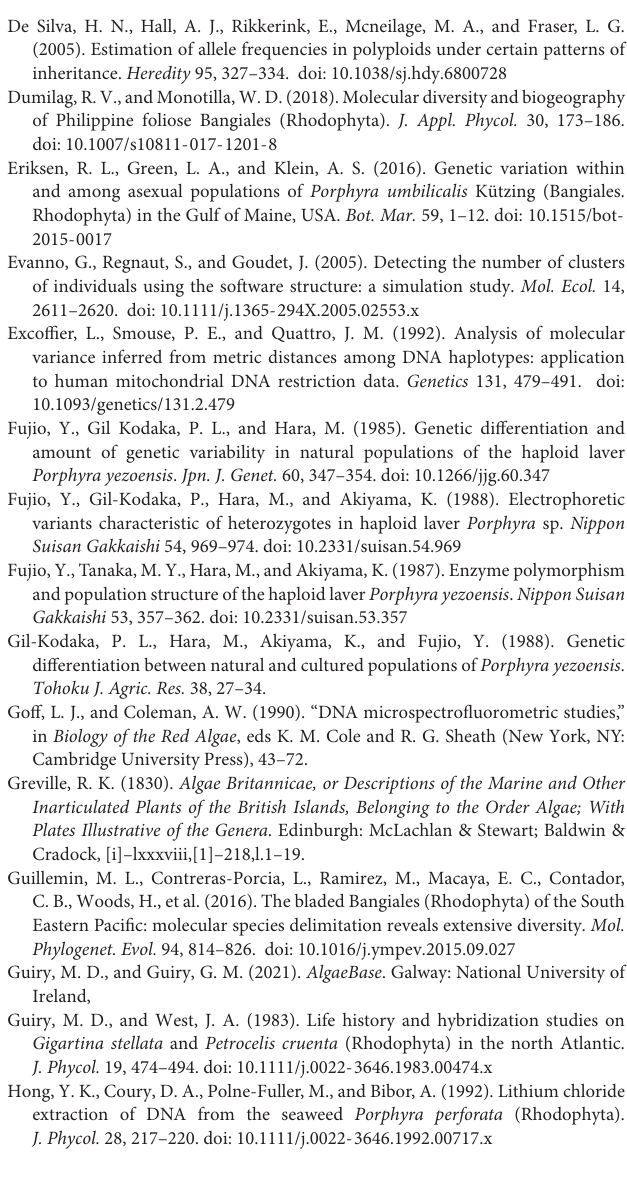
Supplementary Figure 2 | Genome constitution of the 442 genotypes inferred by S TRUCTURE to 2, 3, and 4 inferred clusters based in 10 microsatellite loci, considering the data as 4 × . Supplementary Figure 3 | Genome constitution of the 442 genotypes inferred by S TRUCTURE to 2, 3, and 4 inferred clusters based in 10 microsatellite loci, considering the data as 8 × . Supplementary Figure 4 | Principal component analyses (PCA) based on allelic variation at 10 loci, considering the data as (A) tetraploid 4 × and (B) octoploid 8 × . PCAs with Porphyra linearis genotypes in red (north Europe light red, south Europe dark red), Porphyra dioica genotypes in blue (central Europe dark blue, south Europe light blue), Winter form of P. dioica in blue surrounded by a black circle and hybrids or genotypes with combined genomes in gray. Supplementary Appendix 1 | Input file with the 442 genotypes used in this study. Supplementary Appendix 2 | R Script to run Structure with input file coded as 4 ×